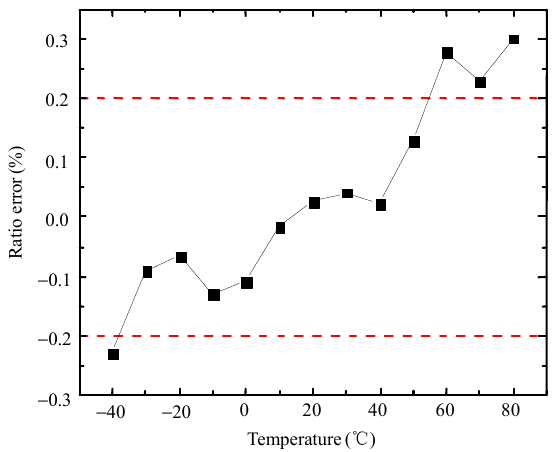
Fig. 7 Test diagram of FOCT ratio error with temperature